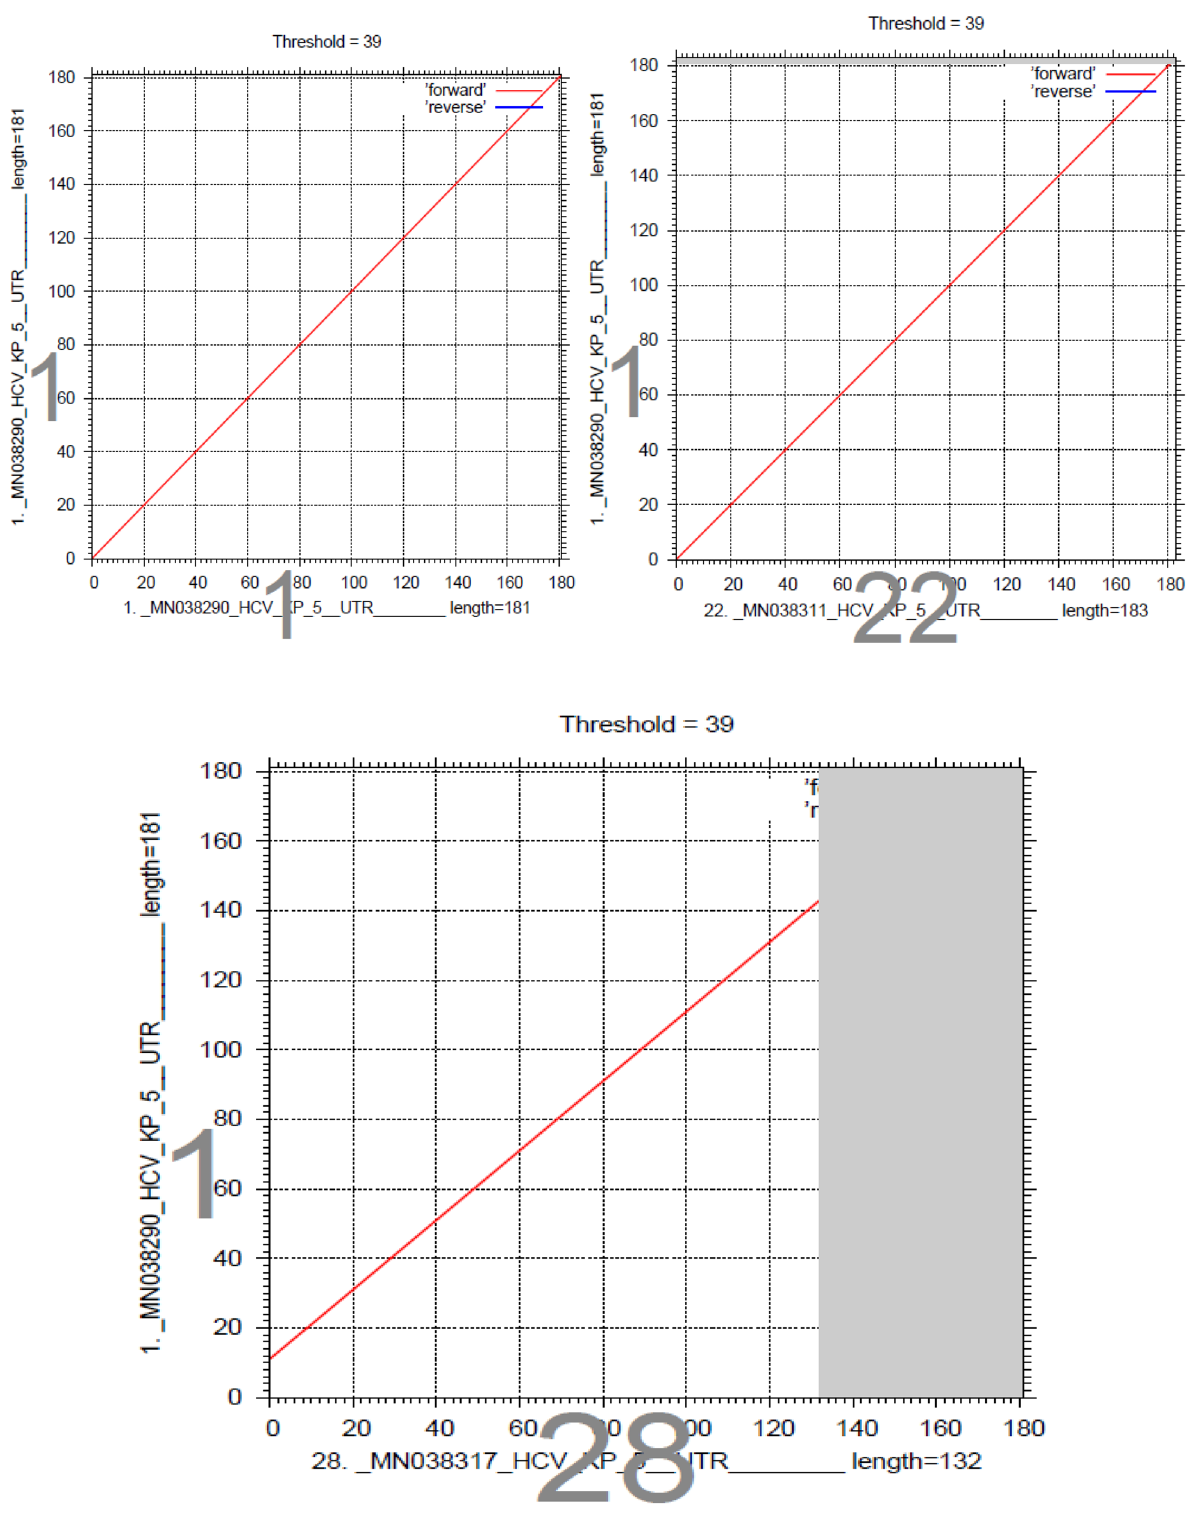
Figure 4. Sequencing of the HCV 5 ʹ UTR was performed with a forward primer (red color), and the nucleotide similarity of the 5 ʹ UTR sequence was checked by using multiple alignment fast Fourier transform (MAFFT version 7 software: https:// mafft. cbrc. jp/ align ment/ server/ large. html). All the sequences show significant similarity with sample 1, and sequence no. 22 shows significant similarity with sequences no. 1 and